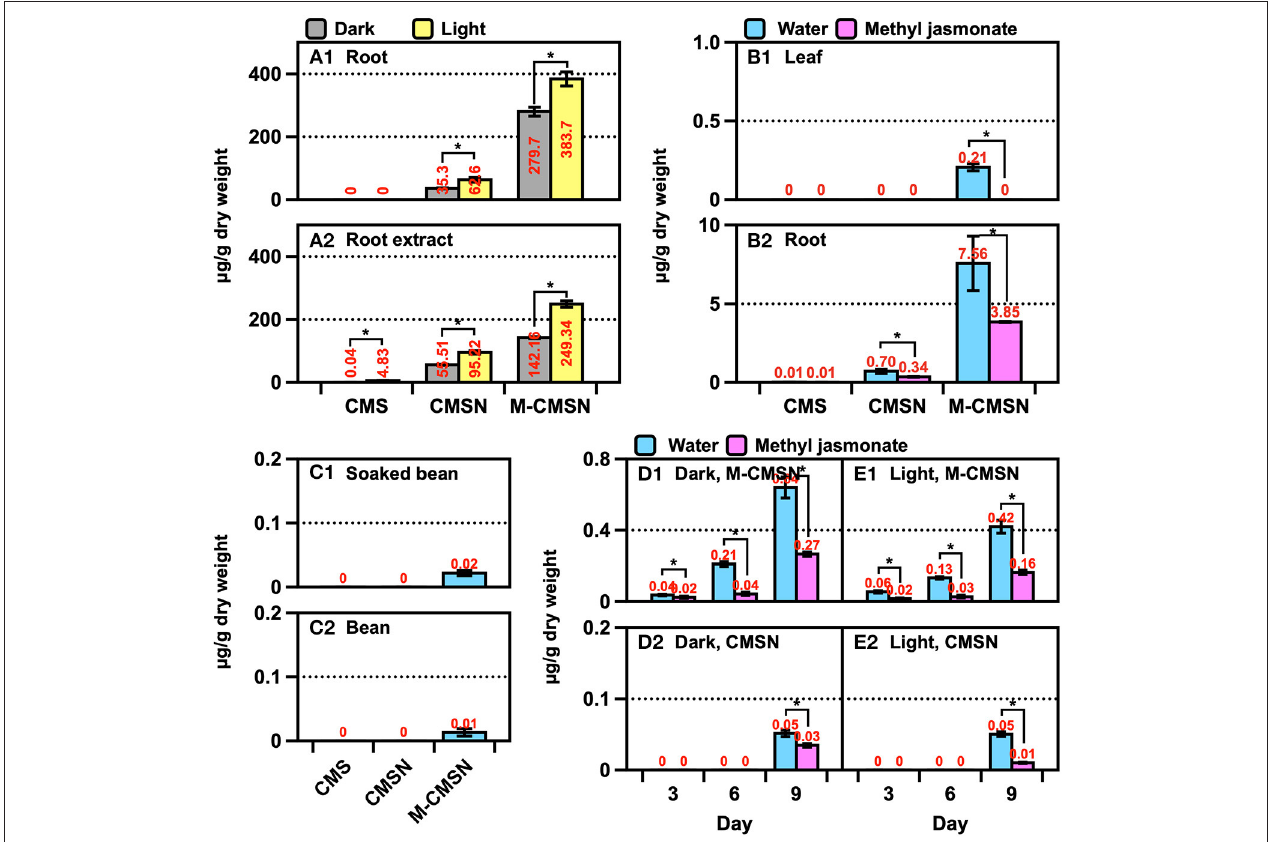
FIGURE 4 | Changes in the CMSN and M-CMSN contents of (A) soybean AR, (B) soybean plants cultivated in artificial soil (AS), (C) untreated and soaked soybean, and (D,E) soybean seedlings. The data are expressed as the mean ± standard error of the mean. Asterisk “*” on the bar indicates significant differences of the comparisons for each pair by Student’s t -test at an α = 0.05